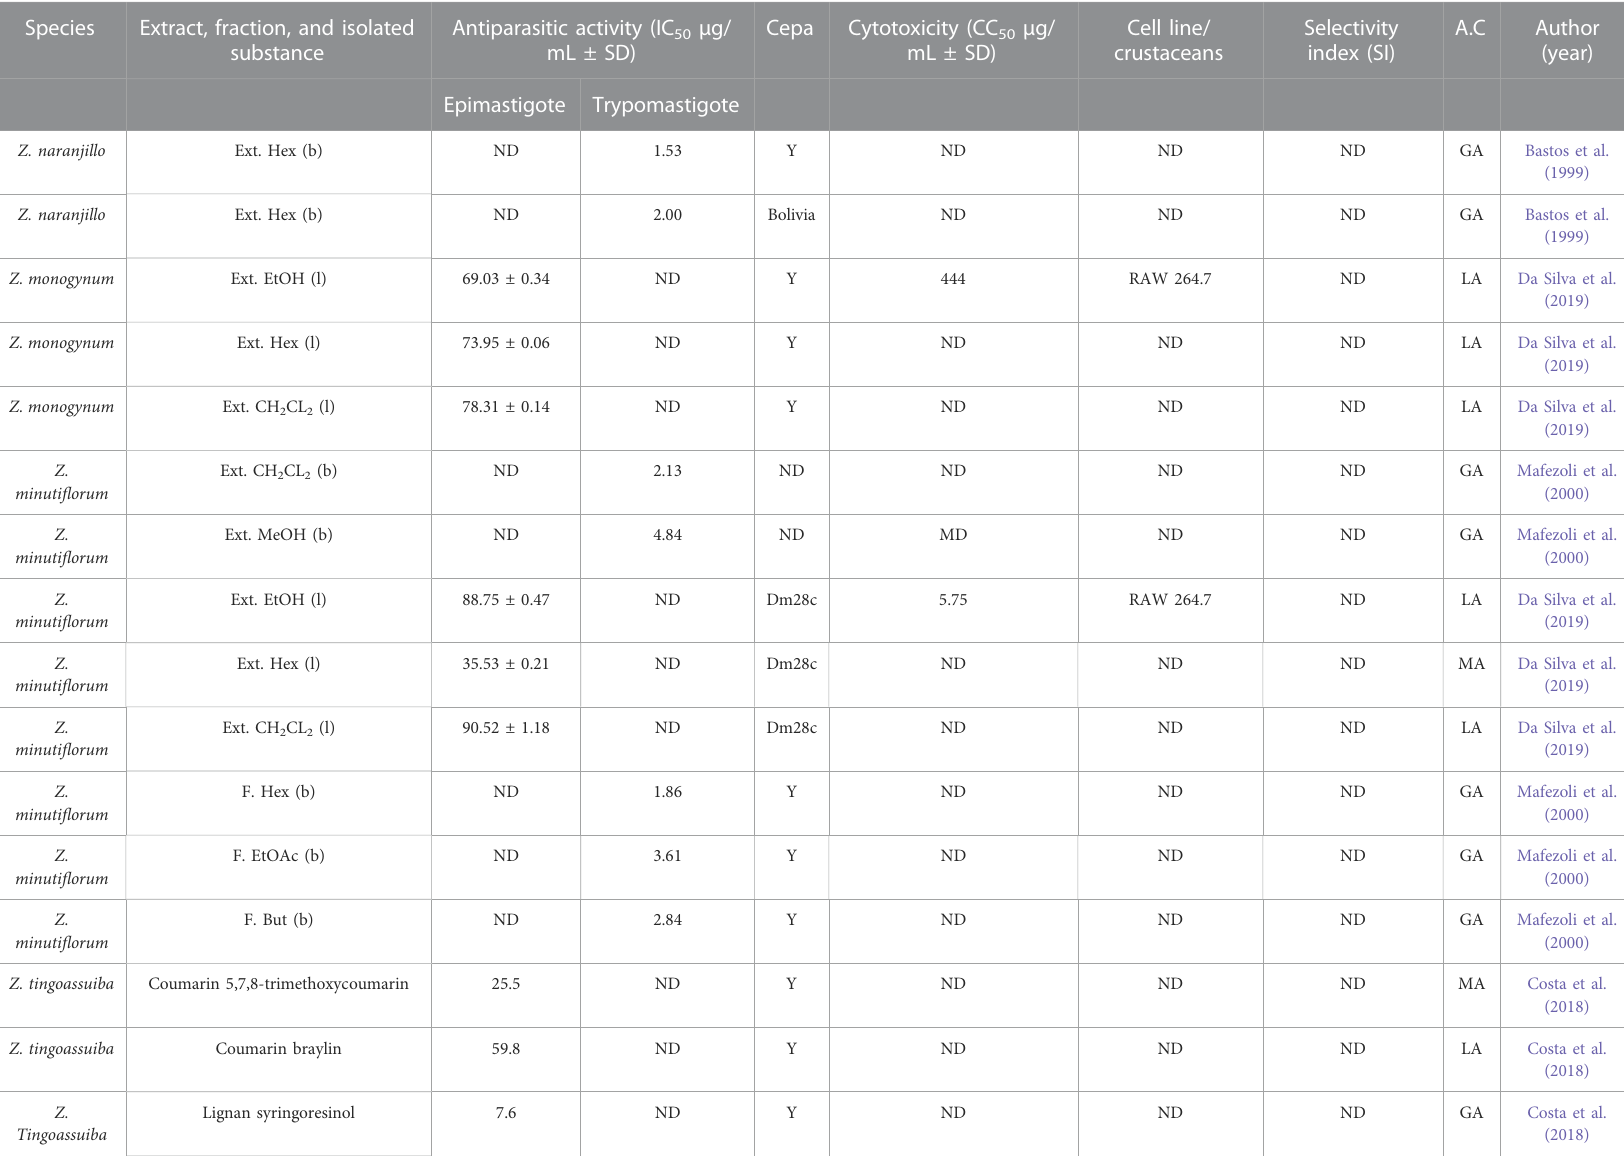
TABLE 7 In vitro antiparasitic activity against Trypanosoma